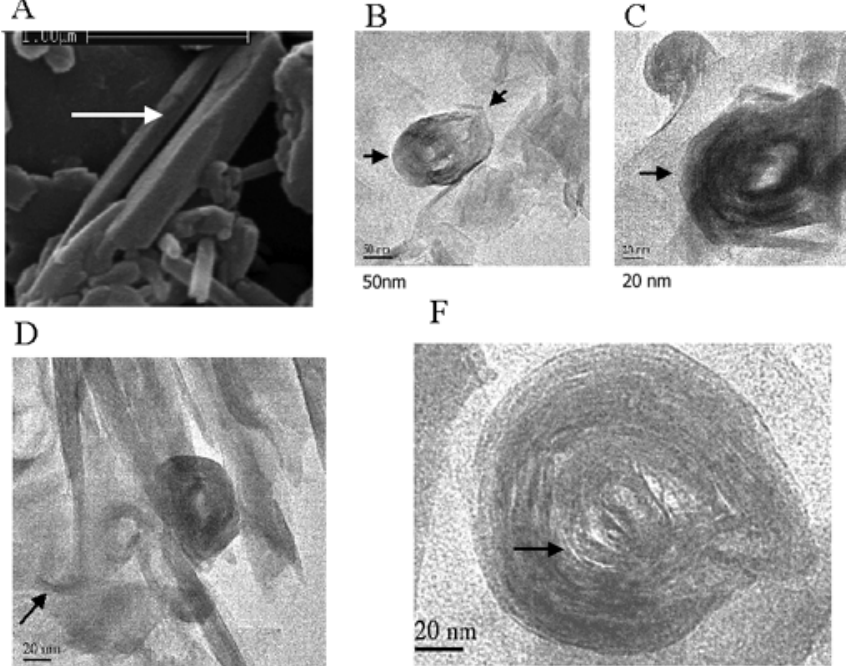
Fig. 9 – Tubes are the most common morphology for halloysite observed using SEM. Planar surface(A)arecommon. TEMobservationsofcross-sectionsofthetubesshowedcurvedshapeas well as polygonal shape in the same particle (B). Other cross sections of tubes are polygonal (C). Some unrolled cross sections form plates (D). Also circular cross-sections with pores between the smoothly curved layers (E) were